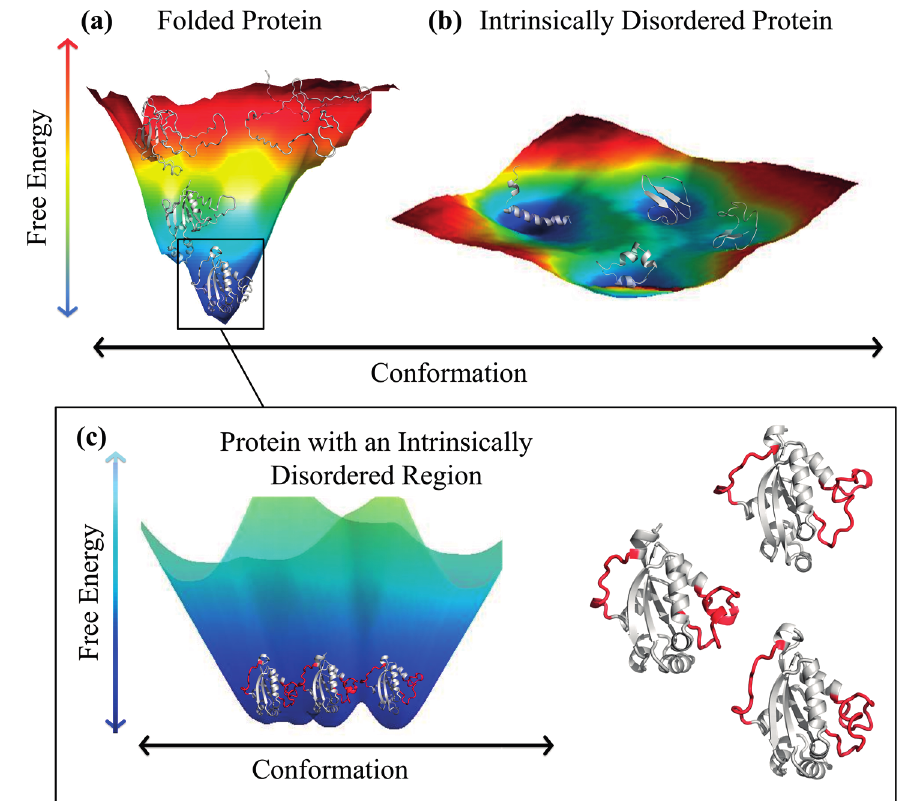
Figure 2. Schematic of energy landscapes for ( a ) a folded protein (human nucleoside diphosphate kinase (NDPK), PDB ID: 1nsk) [45] and ( b ) an intrinsically disordered peptide (CcdA C-terminal, PDB ID: 3tcj) [46]; ( c ) close-up of the minimal free energy well in ( a